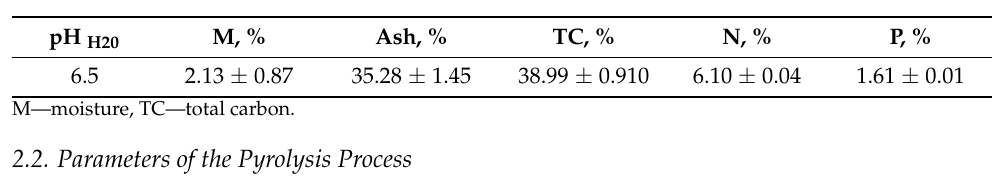
Table 1. Selected properties of poultry manure